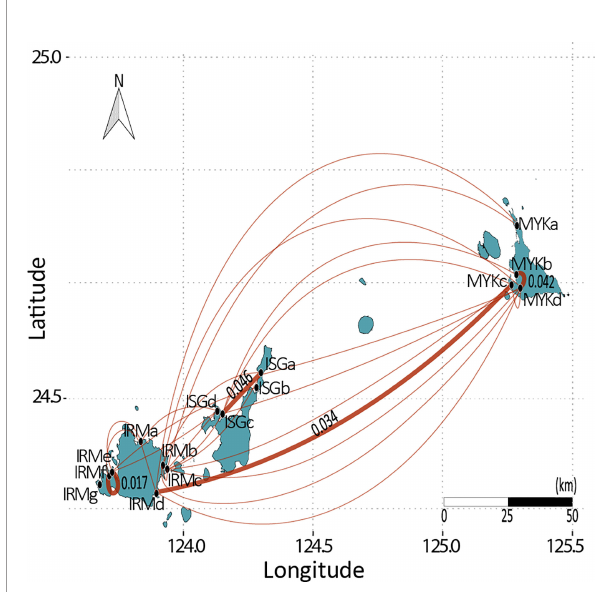
FIGURE 3 | Population pairs with F ST P < 0.1 are projected over the map, and bold lines indicate pairs with F ST P < 0.05, a threshold value indicating signi fi cant